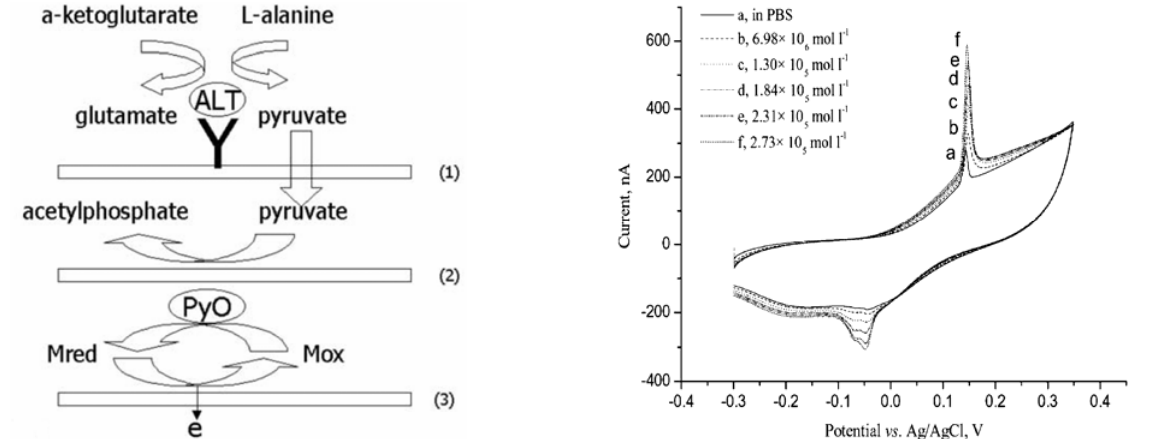
Figure 5. ( Left ) The sequence of electrochemical redox reactions of the two layers of antibody immobilized- and enzyme absorbed-membranes, and a mediator gold electrode. (1) Anti-GPT antibody-immobilized or bare-outer nylon membrane; (2) PyO-absorbed inner nylon membrane; (3) SAM-coated gold-working electrode. ( Right ) Cyclic voltammograms of GPT immunosensor at different concentrations of L -alanine and α -ketoglutarate in PBS (pH 7.4). a, b, c, d, e, and f represent the profiles of oxidation current response at 0, 6.98×10 -6 , 1.30×10 -5 , 1.84×/10 -5 , 2.31×10 -5